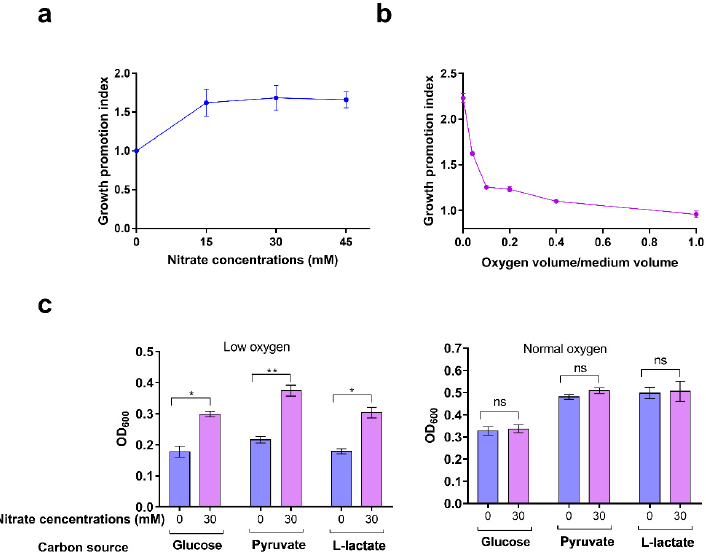
Figure 5. Nitrate utilization promotes S. Typhimurium growth under low-oxygen conditions. ( a ) S. Typhimurium WT strain was cultured in N-minimal medium in the presence of 0, 15, 30, or 45 mM